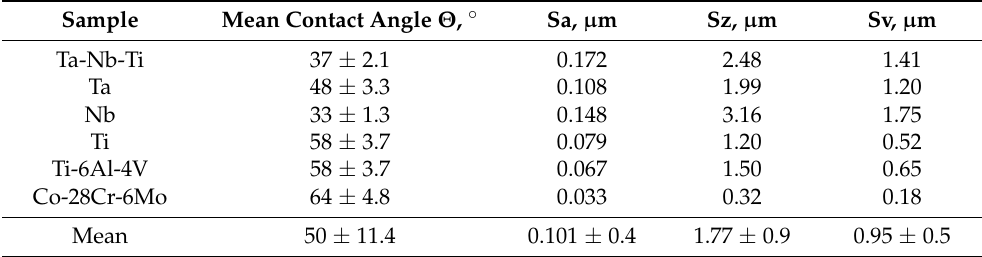
Table 2. Contact angles Θ in water and surface parameters Sa (arithmetic average height), Sz (maximum height) and Sv (maximum recess height) of the samples